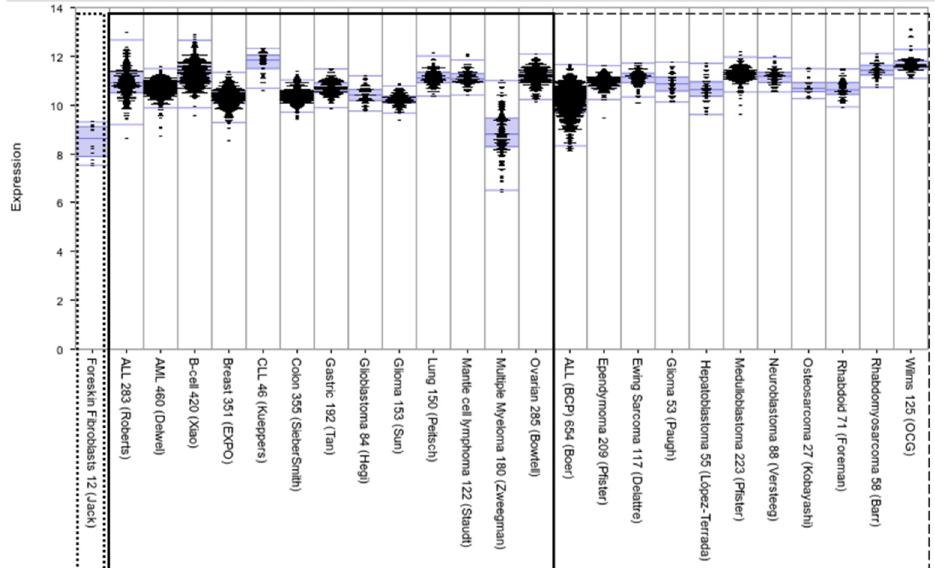
Figure 1. Comparative expression levels of XPO1 in childhood cancers ( right panel , dashed box) and select adult malignancies ( left panel , solid box). XPO1 is expressed highly across malignancies, including adult and pediatric cancers, reflecting the broad clinical implications of XPO1-focused research. Data are from R2 database (http://r2.amc.nl, accessed on 30 June 2021), including foreskin fibroblast (in the dotted box) as representative of baseline expression in normal tissue.